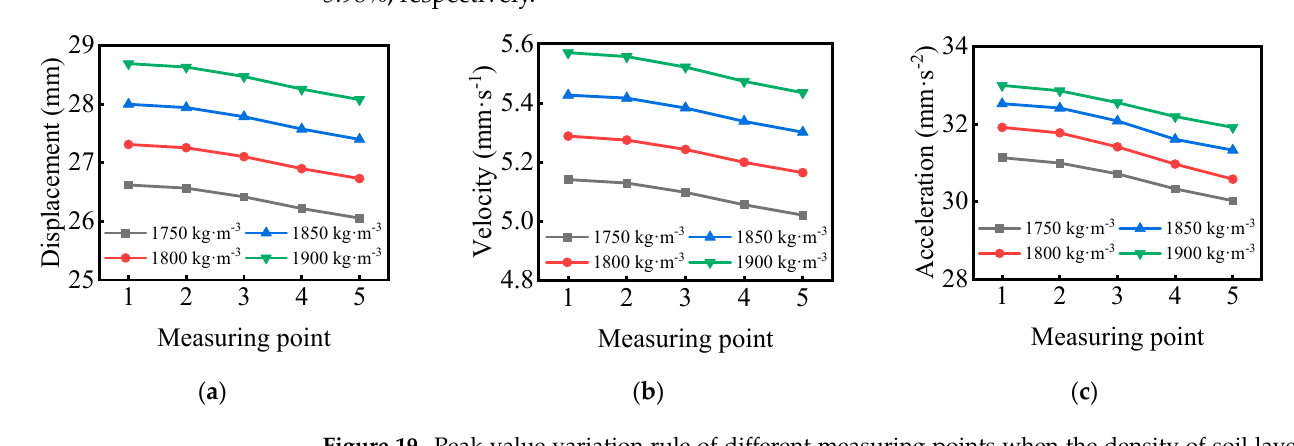
Figure 19. Peak value variation rule of different measuring points when the density of soil layer changes ( a ) displacement, ( b ) velocity, and ( c ) acceleration. Table 5. Results of peak displacement, velocity, and acceleration at the mid − span measuring point when the density of soil layer changes.